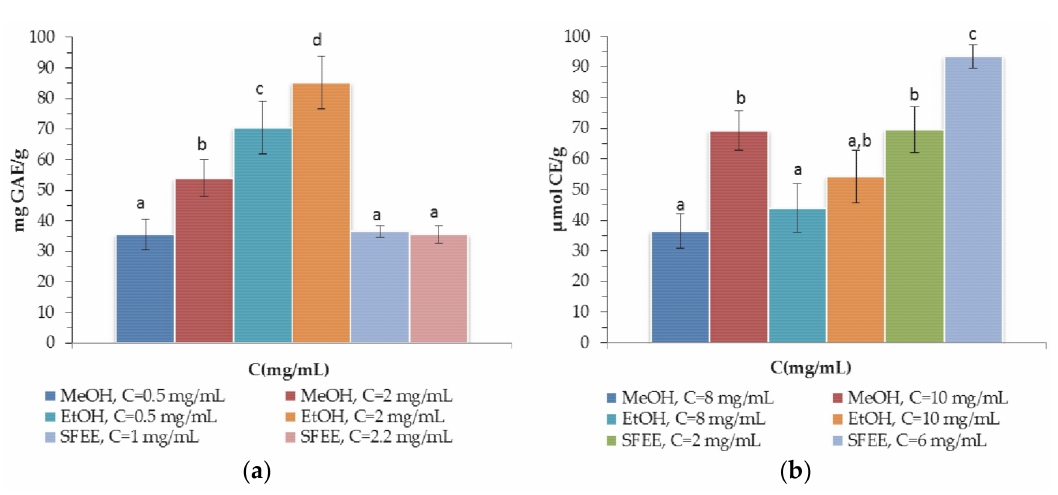
Figure 1. Content of total phenols and flavonoids in basil extract by using different extraction methods. Values with different letters are significantly different ( p ≤ 0.05) according to Tukey HSD and Scheff é tests. ( a ) Total phenolic compounds in basil extract expressed as mg GAE/g extract and ( b ) total flavonoid compounds in basil extract expressed as mol CE/g